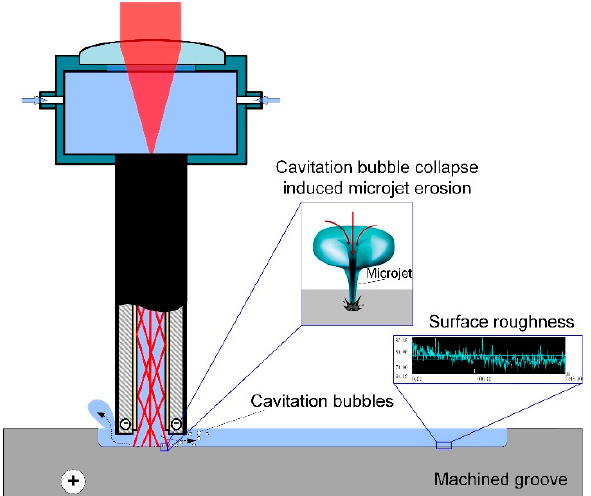
Figure 6. Schematic diagram of the influence of the micro-jet generated by laser-induced cavitation bubble collapse near the solid surface on the surface roughness.